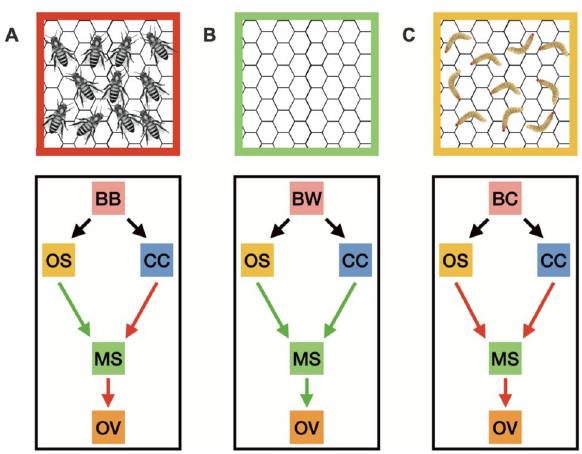
Figure 5. Neuronal models for the interaction between contact-chemoreception (CC) and olfactory system (OS) of wax moth during oviposition site selection . ( A ) Model 1: When the moth senses a BB, the positive signal (green arrow) from their olfactory system to the motor system instigates flight towards the beehive, upon landing on the beehive their contact-chemoreception system senses the presence of bees and sends a negative signal (red arrow) to the motor system (MS), thus restraining oviposition (OV). ( B ) Model 2: Similarly, when a moth senses a BW, positive signals sent to the motor system from both the olfactory and contact- chemoreception system instigates flight towards BW and stimulates oviposition. ( C ) Model 3: However, when a moth senses a BC, the olfactory system sends a negative signal to the motor system thus causing no flight towards